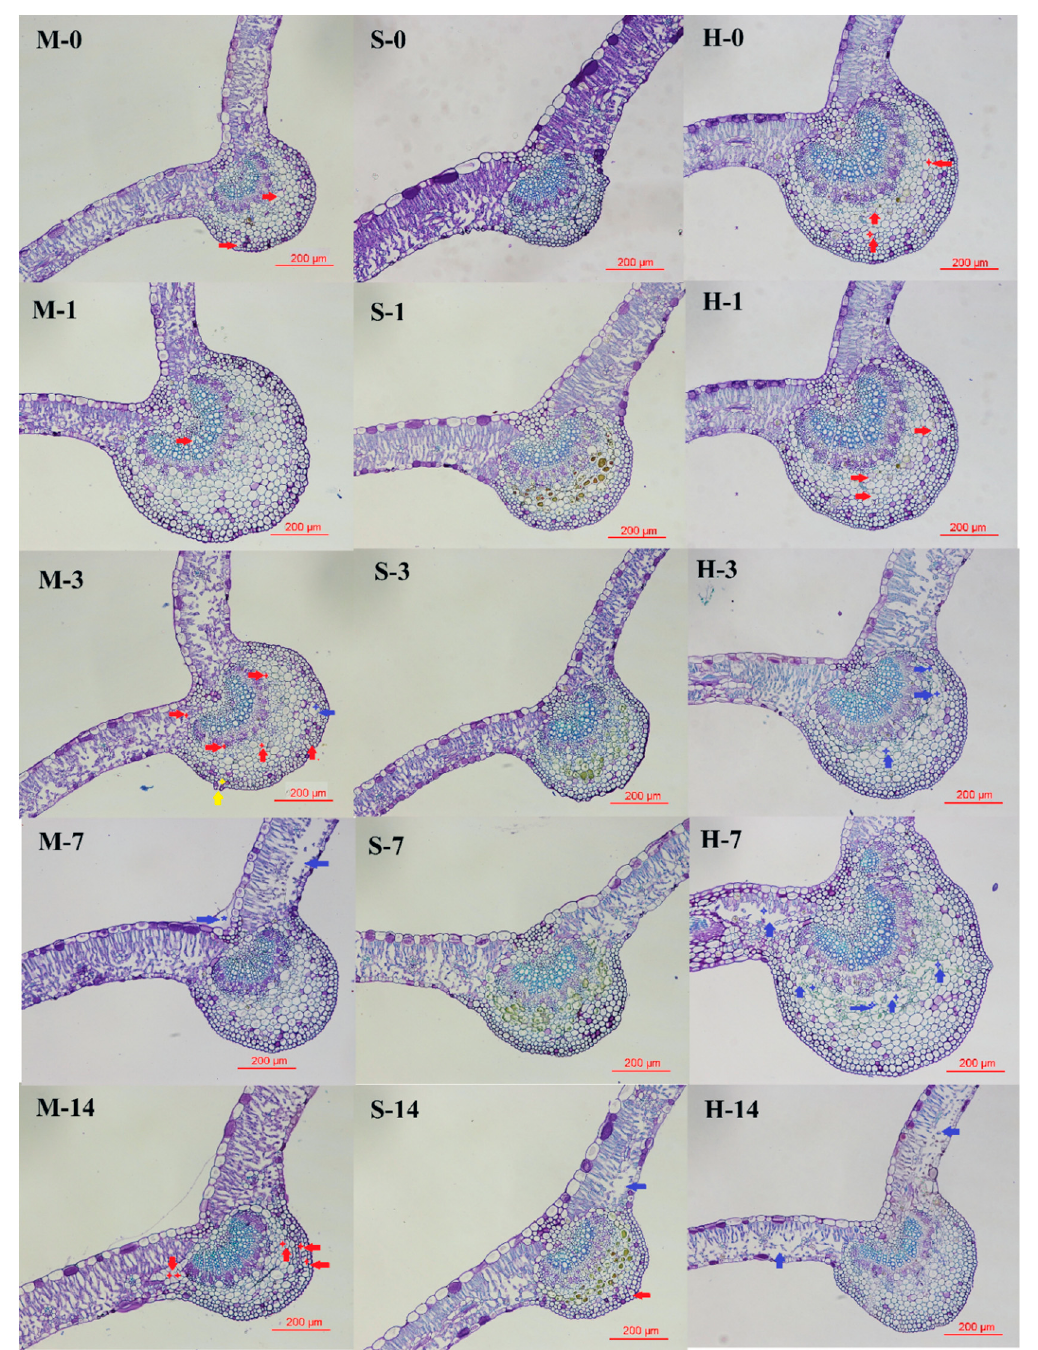
Figure 7. Comparison of anatomical structure changes of leaves of different peach rootstocks under different time duration of waterlogging (yellow asterisk/arrow: lenticular structure; blue aster- isk/arrow: air cavities; red asterisk/arrow: adjacent cells fused with each other; Bar = 200 µ m). Abbreviations: M: Prunus persica, ‘Maotao’; S: Prunus davidiana, ‘Shantao’; H: ‘Hossu’. Leaf